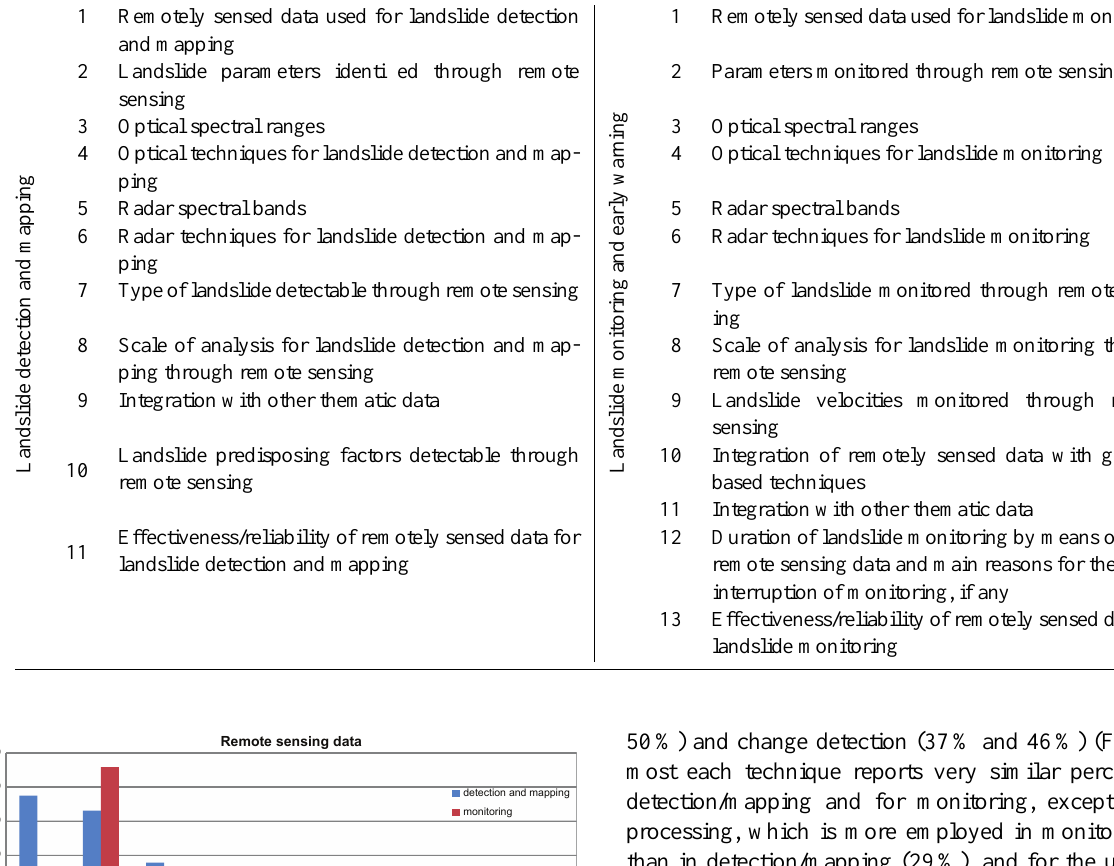
Table 1. Questionnaire overview.